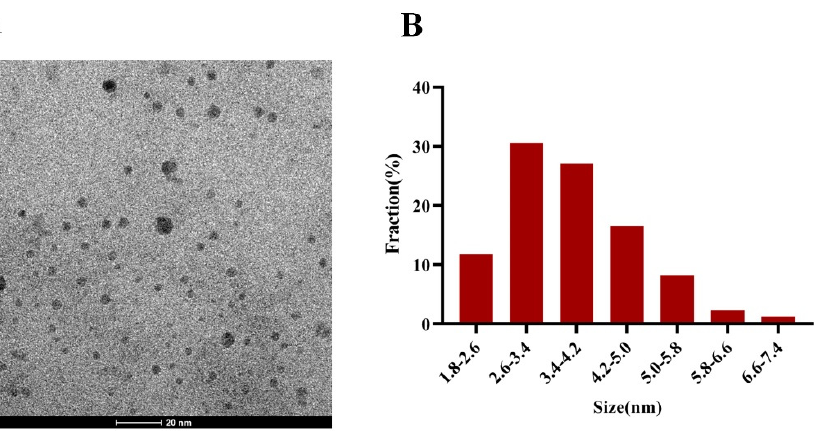
Figure 1. Characterization of hemin-CDs. ( A ) TEM of hemin-CDs conjugates. ( B ) The size of he-